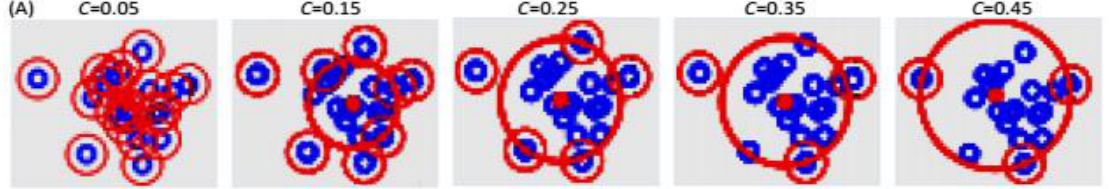
Figure 6. Example of SVDD solutions with: σ = 0 and different values of C , the circled points represent the support vectors.